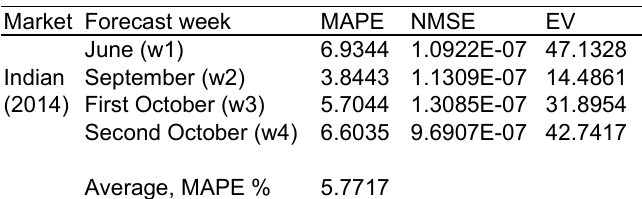
Table 4. Statistical analysis for the four weeks of Indian energy exchange market in the year 2014 using 4-fold cross-validation Market Forecast